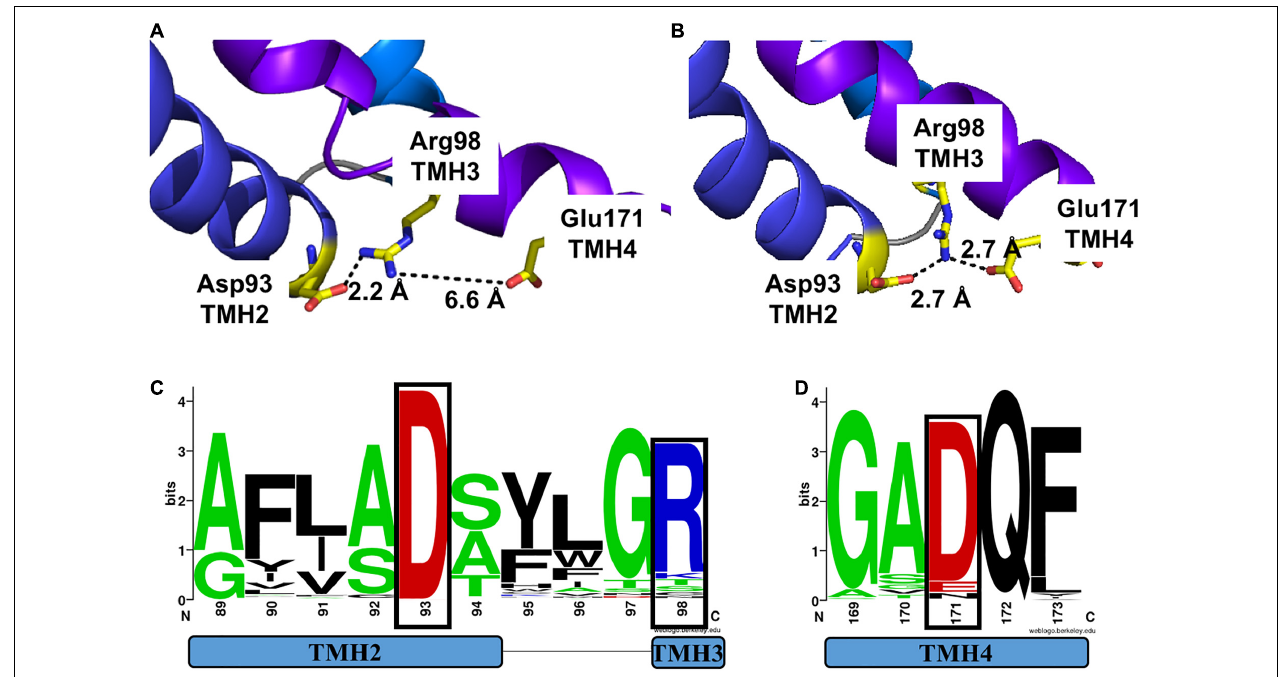
FIGURE 4 | Motif A in two different conformations of MtNPF1.7 and its conservation in plant NPFs. Comparison of the salt-bridge triad in two MtNPF1.7 structural models based on the crystal structure of panel (A) the AtNPF6.3 transporter solved in the I o conformation (pdb: 4oh3) (Sun et al., 2014) or (B) the E. coli YajR transporter solved in the O o conformation (pdb: 3wdo) (Jiang et al., 2013). (A) In the I o conformation, Arg98 forms a salt bridge with Asp93, but Glu171 is too distant (6.6 Å). (B) In the O o conformation Arg98 can form a salt bridge with both Asp93 and Glu171, thanks to the close packing of the TMHs on the cytoplasmic side. (C) Sequence logo of Motif A showing conservation of residues in position +5 (Asp93 in MtNPF1.7) in TMH2 and +10 (Arg98 in MtNPF1.7) in TMH3 (residues in a black box). (D) Sequence logo showing conservation of Glu171 in TMH4. Logos obtained using a collection of 2,380 sequences from plant NPFs (Longo et al., 2018). Numbering based on the MtNPF1.7 sequence. Color scheme: short side chains amino acids (Gly, Ala, Ser, and Thr) are in green; basic (Arg, Lys, His) in blue; acidic (Asp and Glu) in red; others in